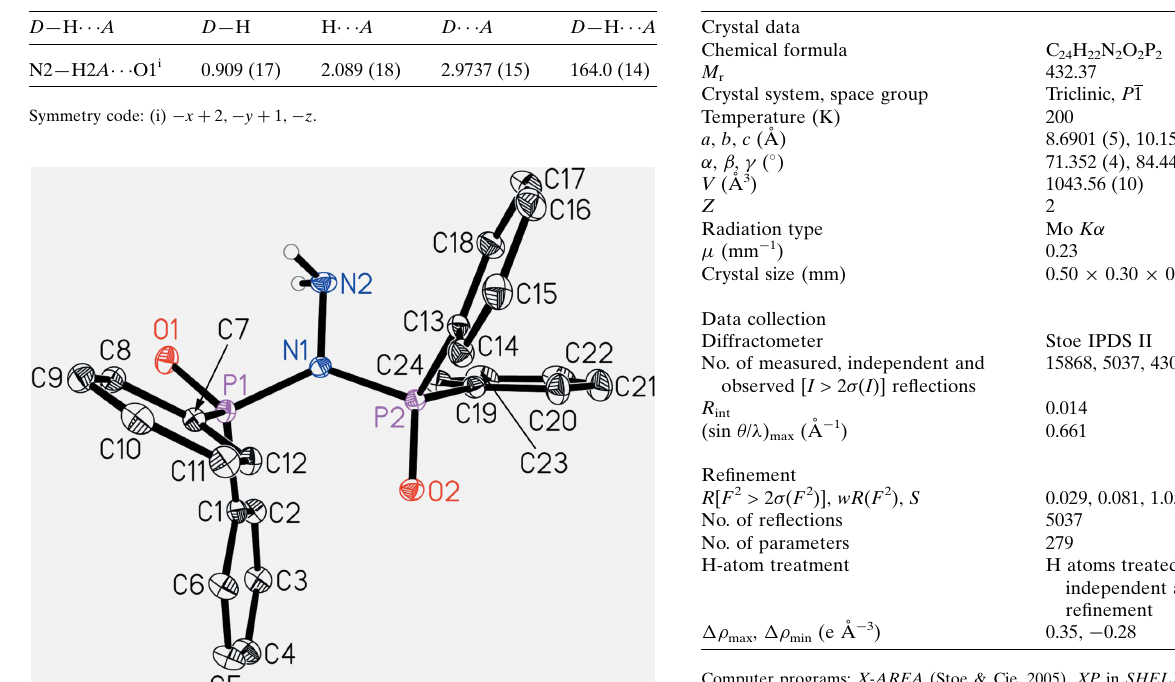
Table 1 Hydrogen-bond geometry (A˚ , (cid:3)